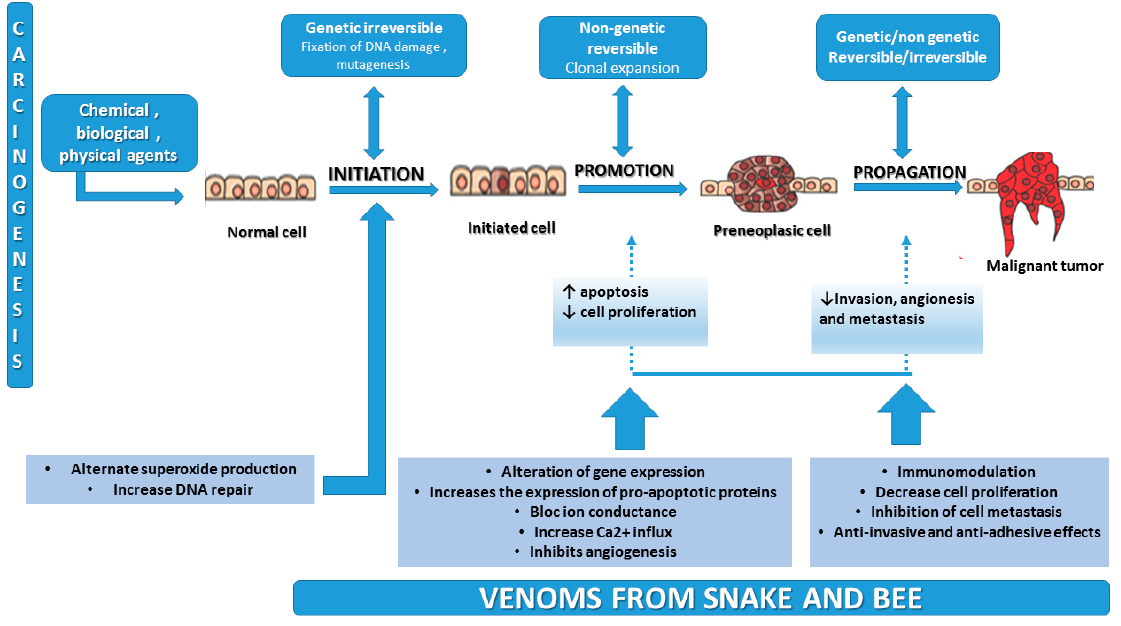
Figure 1. Carcinogenesis and the effects of toxins from snake and bee venom on the different steps of the process (adapted from [17,18]).